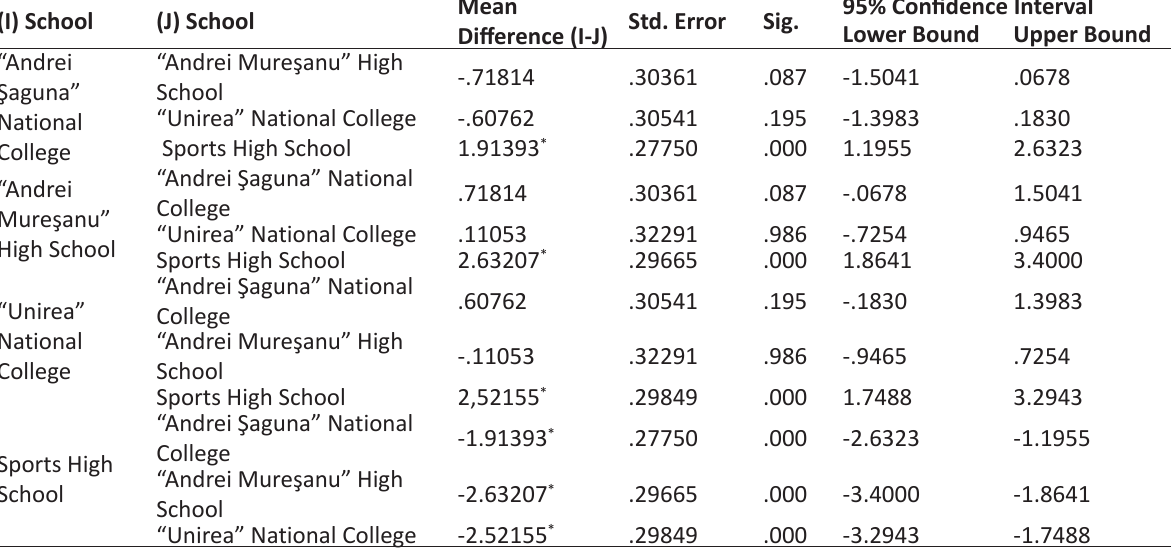
Table 2. Body mass index in male subjects depending on the school – multiple comparisons a with Tukey Hsd (I)